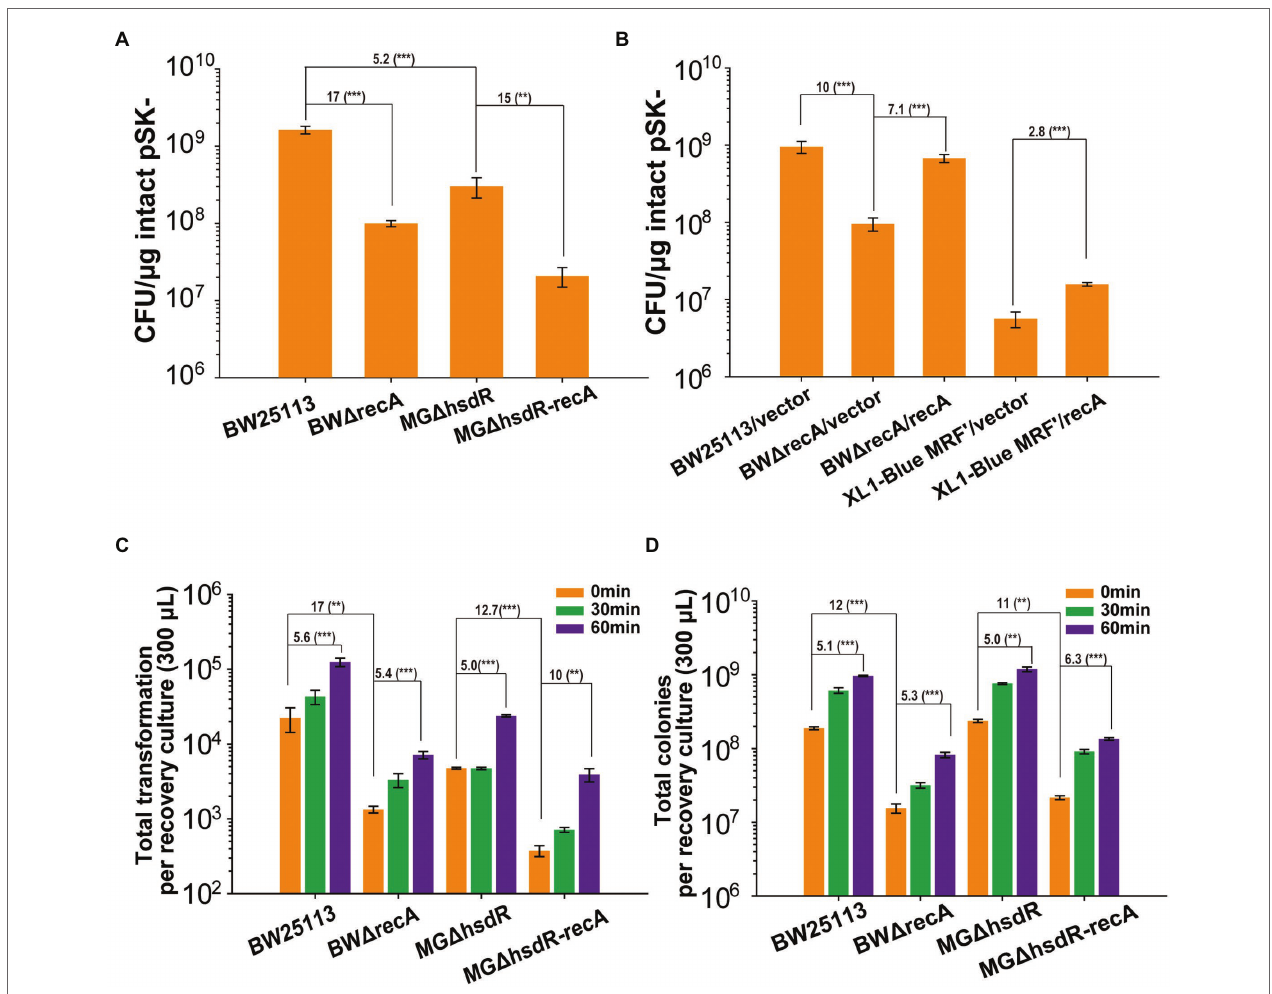
FIGURE 2 | The deletion of recA affects TE and cell viability. (A) The TEs of competent cells prepared with TSS for three strains and their recA mutants. (B) The TEs was recovered by complementing the RecA function in the recA mutant of BW25113 and XL1-Blue MRF’. (C) The transformant colonies of recA mutants and their parent wild-type strains formed on LB plates with the Amp antibiotic after recovering in LB medium for 0 to 60 min. (D) Total colonies of recA mutants and their parent wild-type strains formed on LB plates without antibiotic after recovering in LB medium for 0 to 60 min. Intact pSK- was used for transformation. Unpaired t-tests were performed (** = p < 0.01 and *** = p < 0.001). The numbers before (***) represent the difference by folds. Data are averages of three samples with standard deviations (error